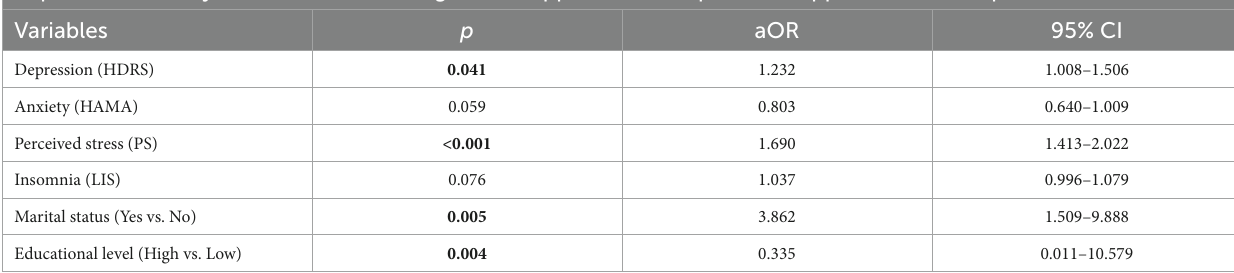
TABLE 3 Adjusted odds ratios with their 95% confidence intervals from the logistic regression of ischemic stroke among cases and control. Logistic regression taking the presence vs. absence of ischemic stroke as the dependent variable and taking depression, anxiety, PS and insomnia, cognitive reappraisal and expressive suppression as independent